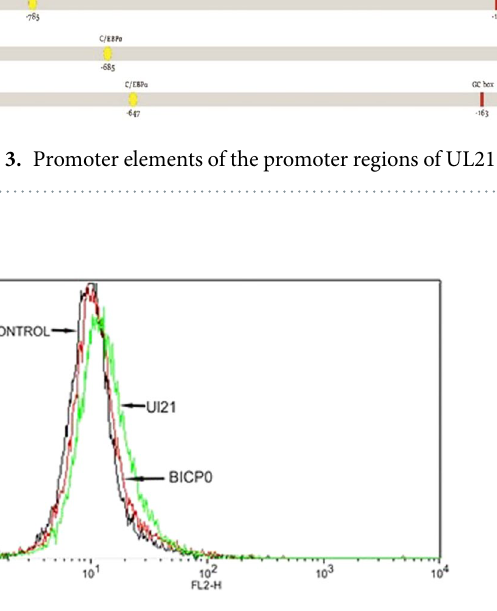
Figure 4. Basal promoter expression by flow cytometry: UL21 shows higher expression compared to BICP0.